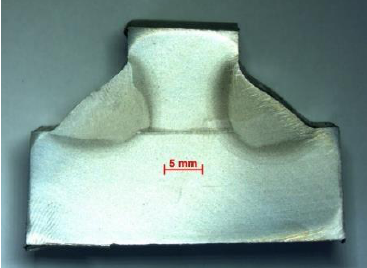
Figure 12. Macrostructure of a double-sided fillet weld of a crushing hammer.